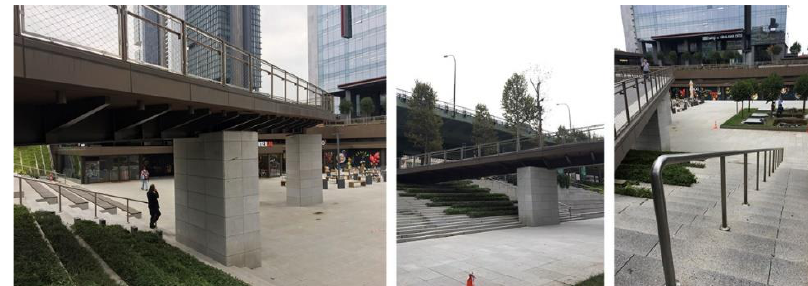
Figure 5 Open spaces of Torun Center (Photograph credits: personal archive of Feride Gül Keleş,